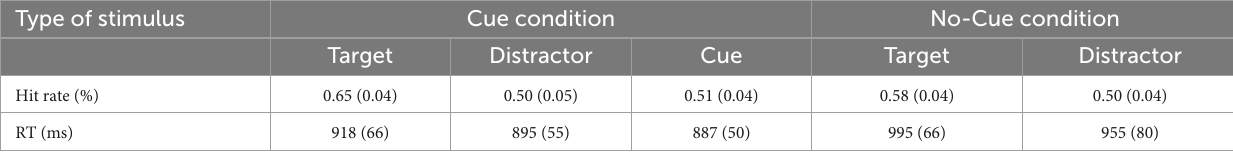
TABLE 1 Overall performance on word recognition test in Experiment